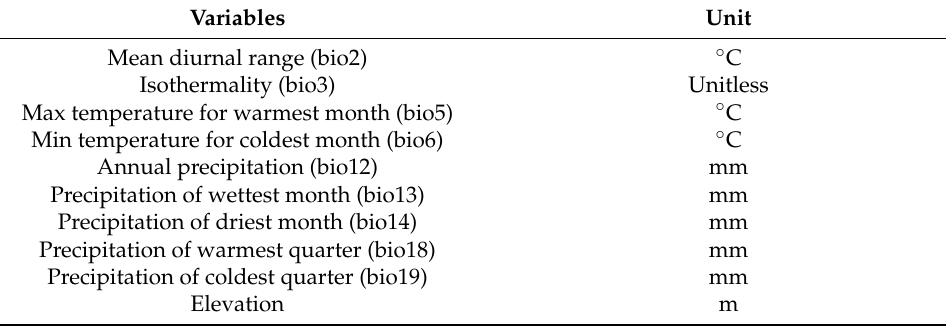
Table 1. Environmental variables used for modelling the suitability habitat of Baer’s Pochard in the